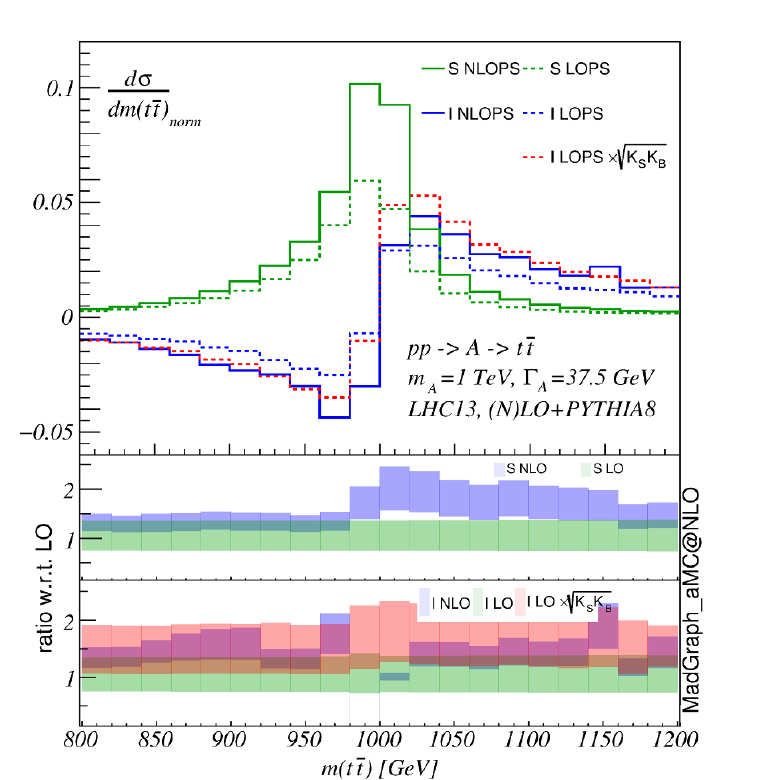
Figure 15 . Signal and interference lineshapes at (N)LO matched with PS for LHC 13 TeV. Re- sults are normalised to the SM fNLO lineshape. Lower panels show the K-factors and the scale uncertainties of signal and interference respectively.